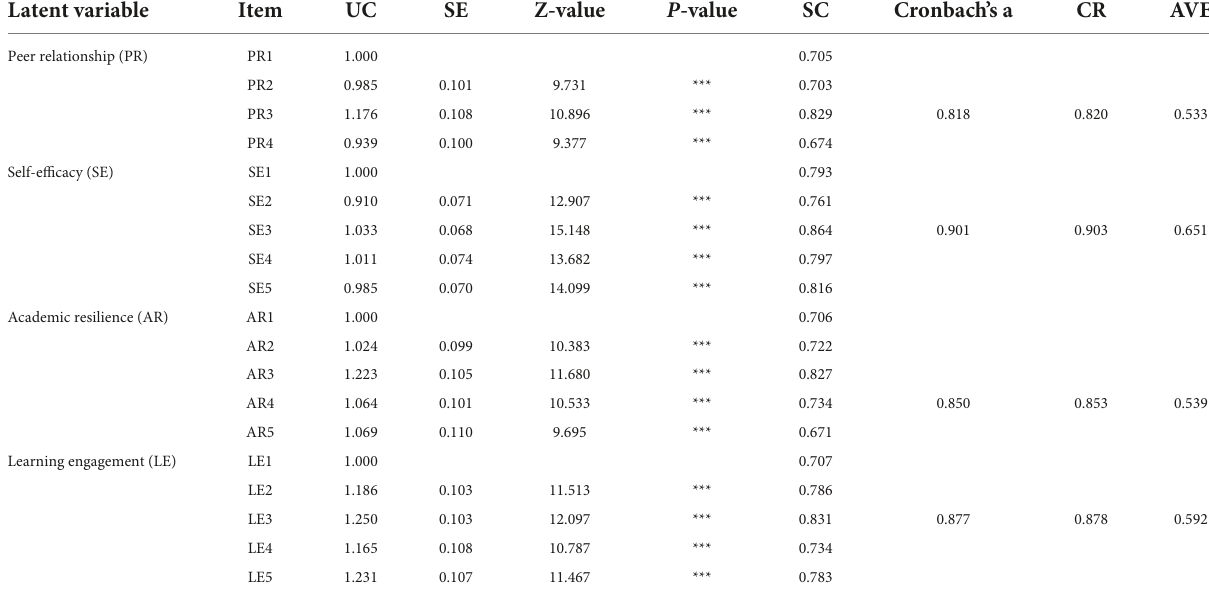
TABLE 3 Reliability and validity examination.